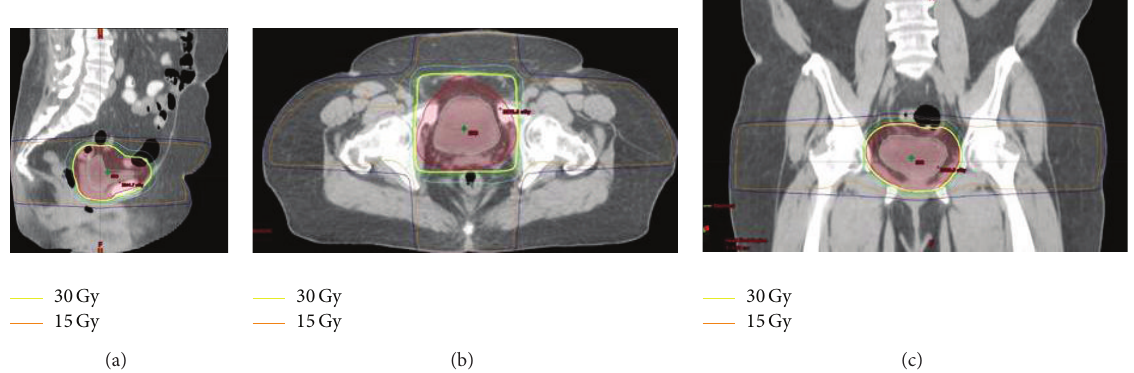
Figure 2: 3D conformal radiation therapy of MALT lymphoma of the bladder with dose distributions depicted in the sagittal (a), axial (b), and coronal (c)